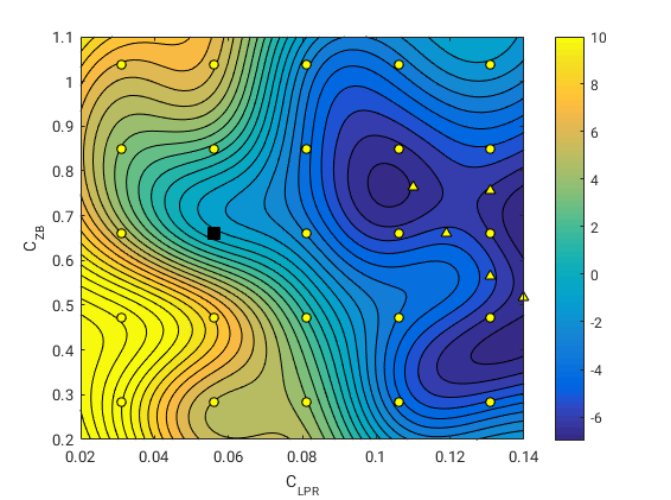
Figure 14. Improved surrogate using infilling. The square represents the starting geometry and the circles represent the new geometries. The triangles represent the infill points used. The color scale represents the resistance variation in reference to the original geometry (where negative values indicate resistance reduction, and positive values indicate resistance increment).